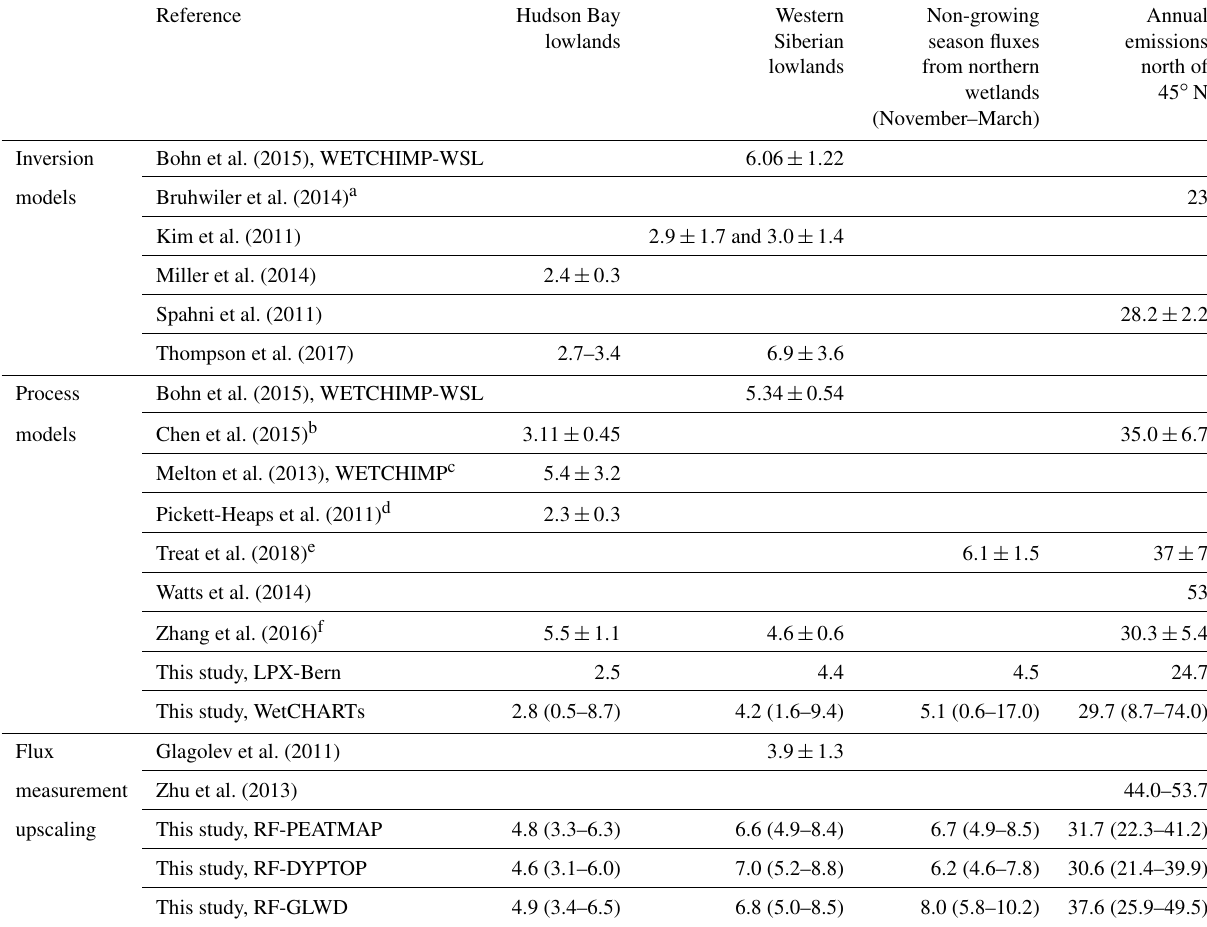
Table 2. Annual CH 4 wetland emissions in different subdomains (Hudson Bay lowlands and western Siberian lowlands; see Fig. 1) and time periods. The values are given in Tg(CH 4 )yr − 1 . Note that estimates from some reference studies are not for the same period as the one studied here (2013–2014). For WetCHARTs the mean of the model ensemble together with the range (in parentheses) is given, whereas for the upscaling results the 95% confidence intervals for the estimated emissions are